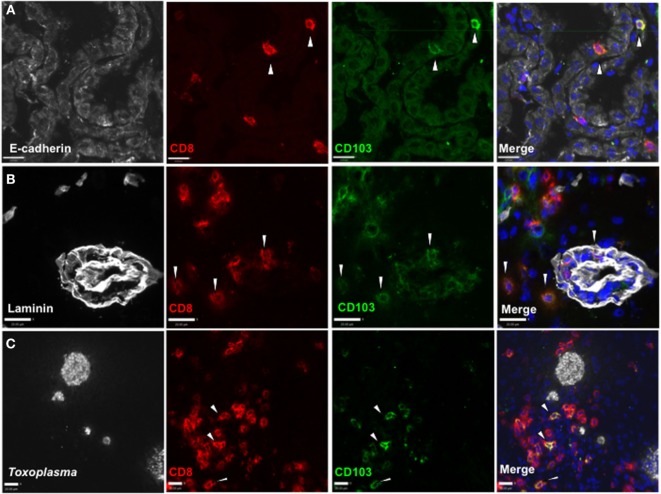
Distribution of CD103+ CD8 T cells in the Toxoplasma gondii-infected brain. Immunofluorescent staining in situ for CD8 and CD103 in representative sagittal section-infected brain at 5 weeks postinfection. (A) E-cadherin staining in choroid plexus of lateral ventricle, 40× magnification, zoomed in. (B) Laminin staining for vasculature of frontal cortex, 40× magnification, zoomed in. (C)
T. gondii staining in the frontal cortex, 25× magnification, zoomed in. All images are representative of n = 3 biological replicates at 5 weeks post infection. White arrows indicate examples of staining positive for both CD8 and CD103. Scale bar indicates 20 µm.